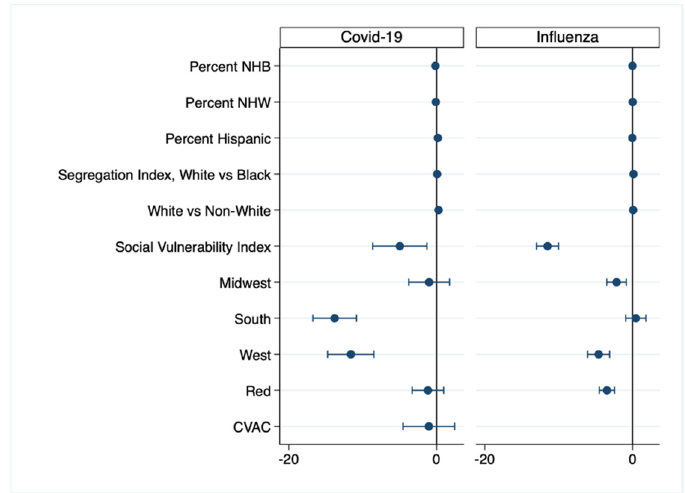
Figure 6. Coefficient plots for the fully adjusted multiple regression models of COVID-19 and Influenza vaccination rates. Horizontal bars represent 95% CIs. Left of the 0 line (negative numbers) indicates lower COVID-19 vaccination rates.